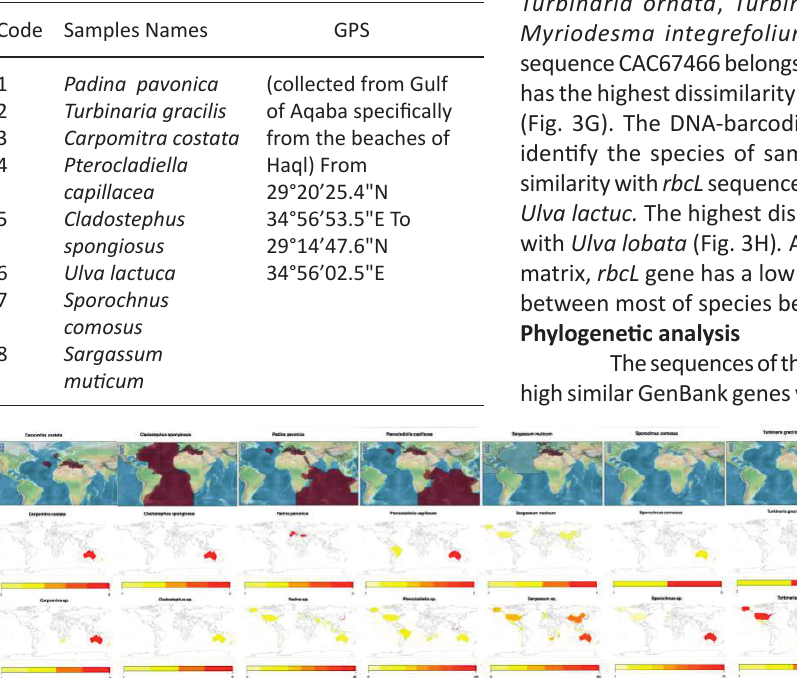
Table 2 . The details for the 8 seaweeds samples after DNA sequencing